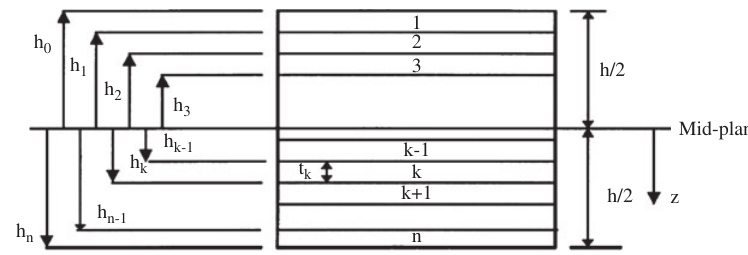
Figure 1 Coordinate locations of plies in a